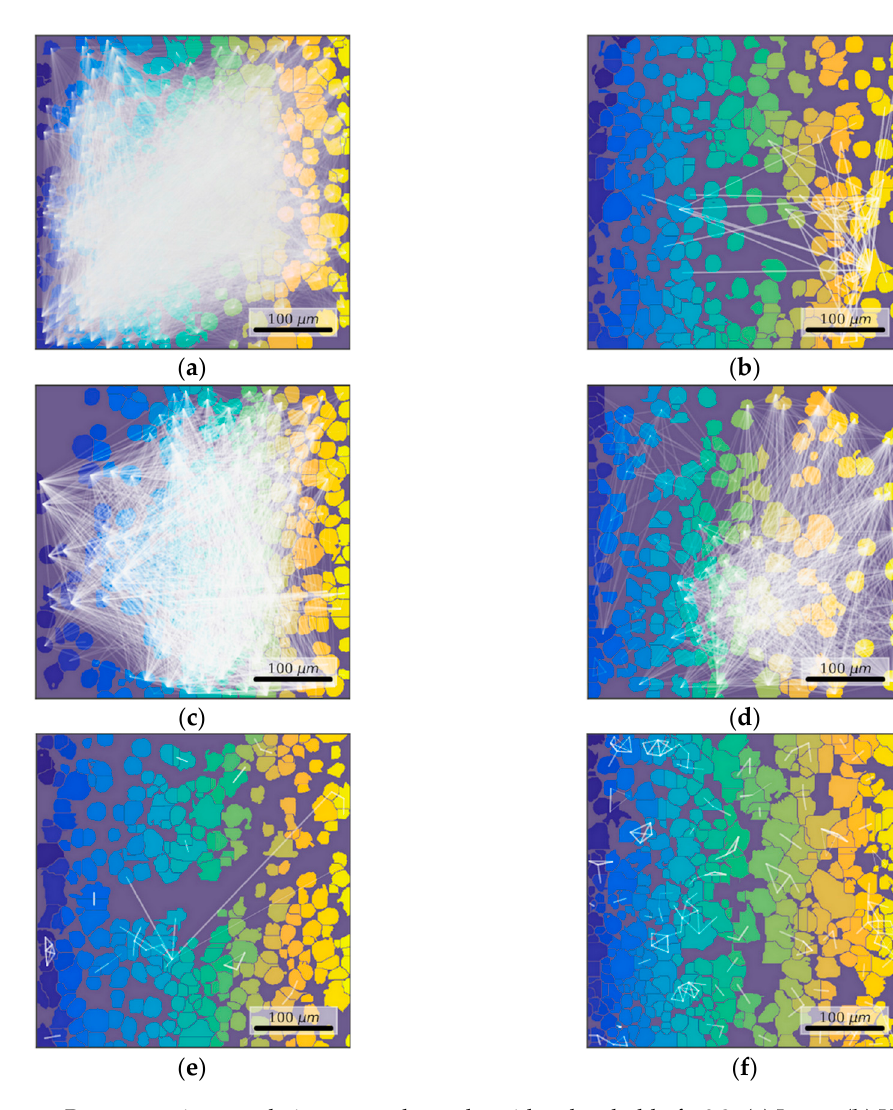
Figure 7. Representative correlation network graphs with a threshold of > 0.3. ( a ) Intact; ( b ) Hypoxia; ( c ) Hypoxia and neuradapt 1 μ M, immediate treatment; ( d ) Hypoxia and neuradapt 15 μ M, immediate treatment; ( e ) Hypoxia and neuradapt 1 μ M, post ‐ treatment; ( f ) Hypoxia and neuradapt 15 μ M, post ‐ treatment.